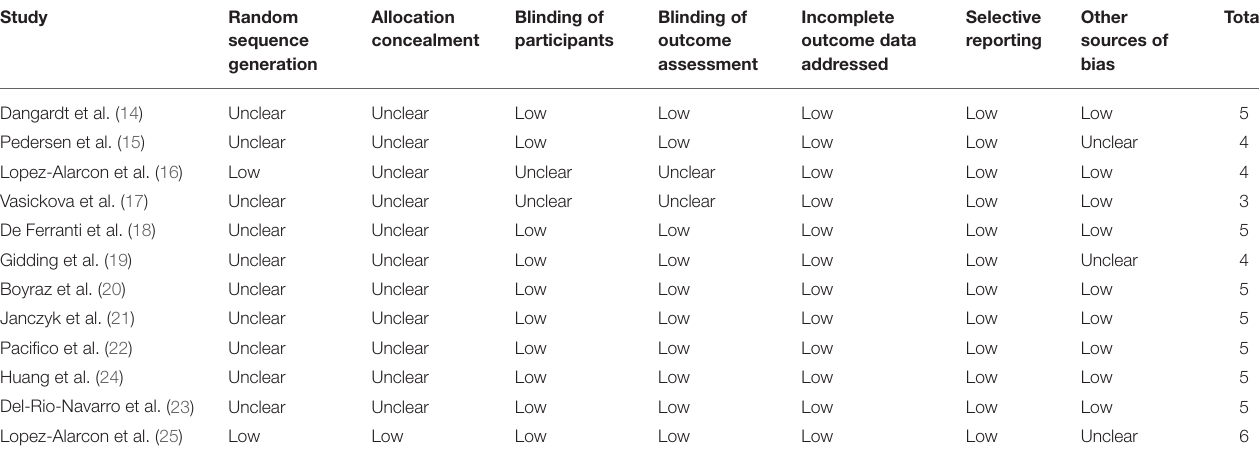
TABLE 2 | Quality evaluation of the included studies via the Cochrane’s Risk of Bias Tool.